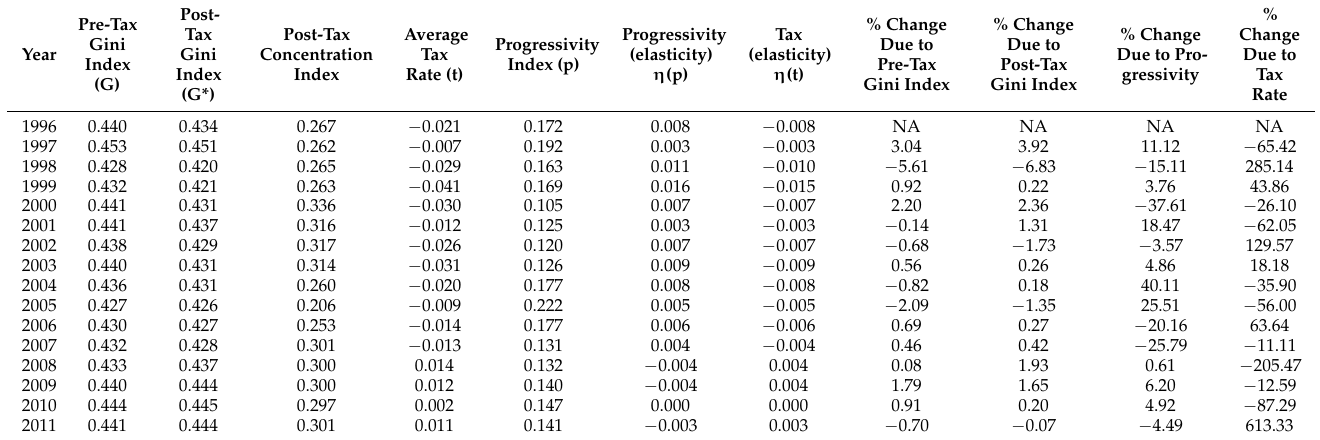
Table 5. Tax progressivity for African American CPS respondents for years 1996 to 2011.